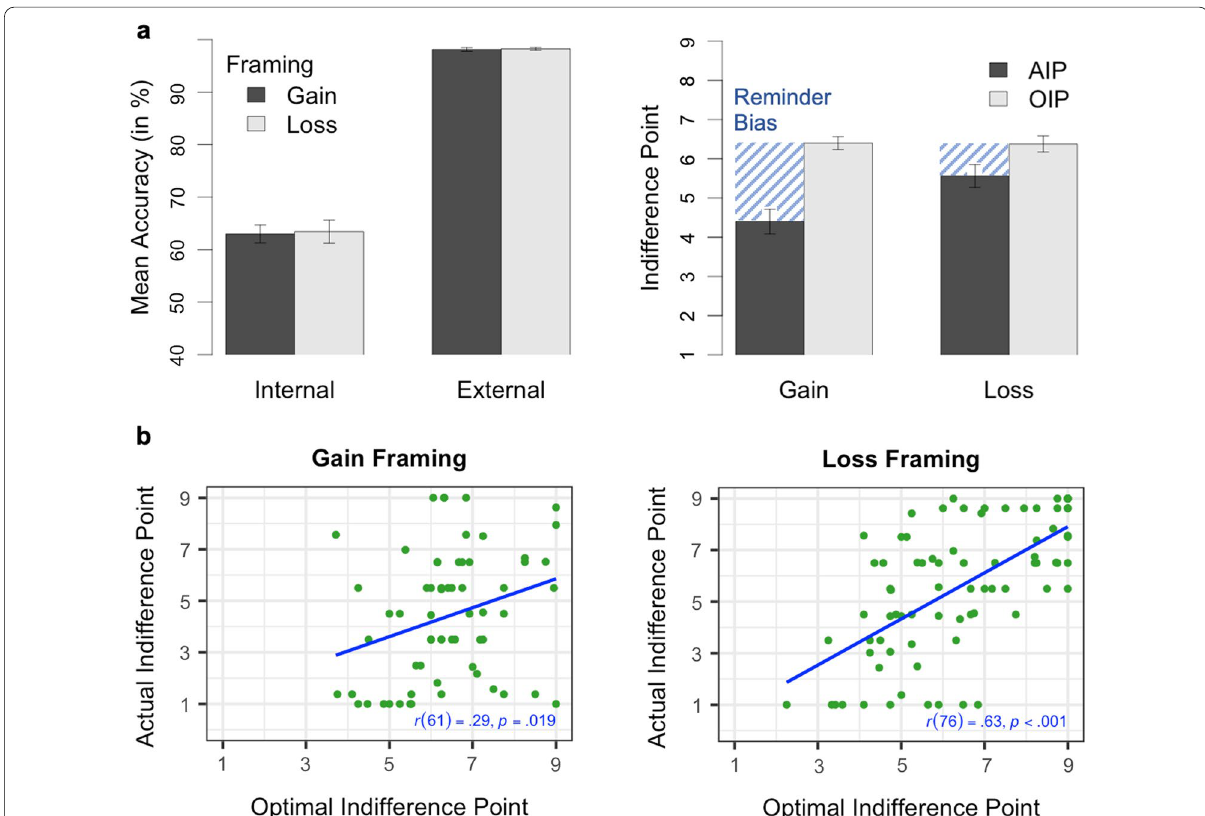
Fig. 3 Results on Offloading Behavior from Experiment 1. Note a In the left panel, mean accuracy for the forced‑internal and forced‑external trials in the gain and loss framing conditions. Mean optimal (OIPs) and actual indifference points (AIPs) as a function of framing condition in the right panel. The line pattern illustrates the size of the reminder bias defined as OIP minus AIP. b Correlation between actual and optimal indifference points for the gain (left panel) and loss (right panel) framing condition. a Error bars represent standard